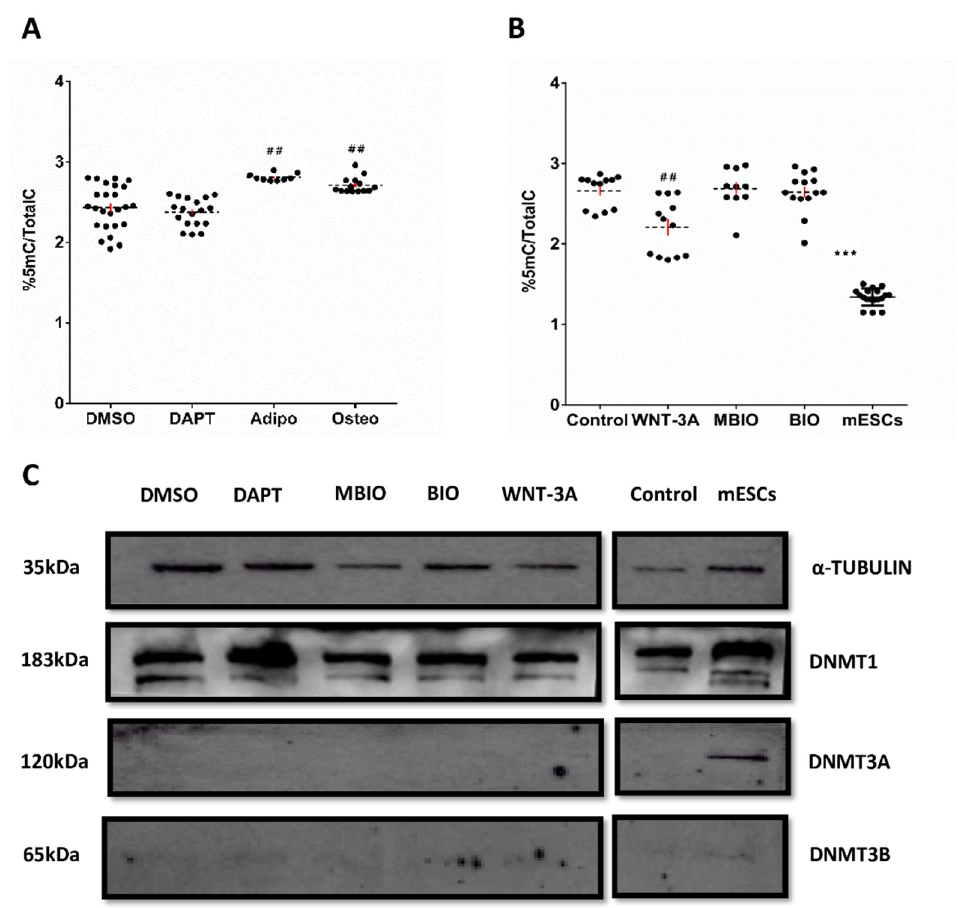
Figure 3. Notch and Wnt signaling regulate genomic DNA methylation in DPSCs. ( A , B ): Global DNA methylation levels in DPSCs showing the proportion (%) of 5 mC with respect to total C in control (DMSO, MBIO) with respect to DAPT, BIO, WNT-3A and di ff erentiation induction conditions. Mouse ESCs were used as a control for low DNA methylation. Data are presented as the mean + SEM (n = 8). ##: p < 0.01, ***: p < 0.001; Dunn’s post-hoc test, Kruskal- Wallis H Test. ( C ): Representative WB showing DNMT1, DNMT3A and DNMT3A expression in DPSCs under di ff erent treatments. α -TUBULIN was used as a protein loading control. Mouse ESCs were used as a positive control for DNMT protein expression (right panel). Control on right panel shows untreated DPSCs grown in standard conditions.